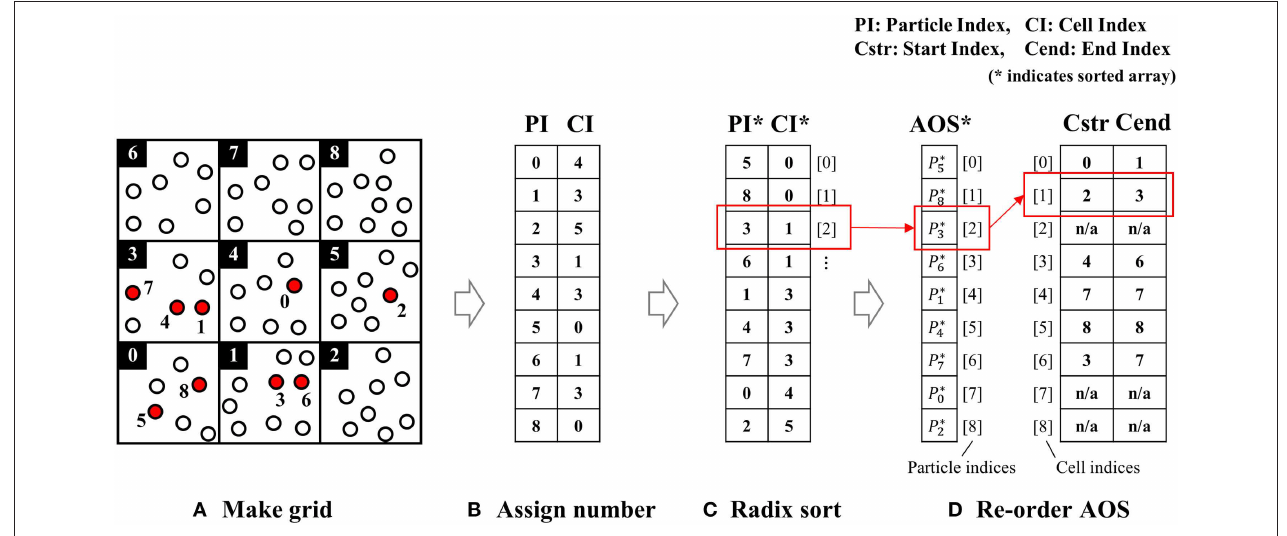
FIGURE 5 | A demonstration of nearest-neighbor particle search by sorting. (A) Make grid, (B) assign number, (C) radix sort, and (D) re-order